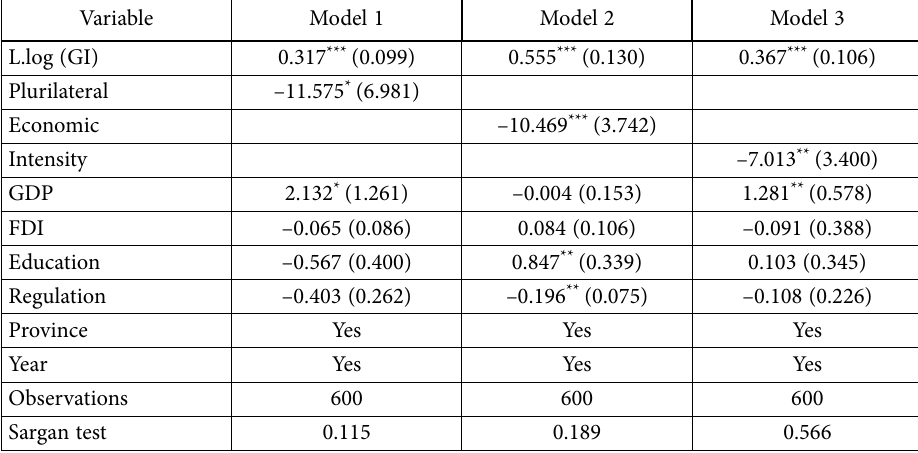
Table 4. Estimation results of the DIF-GMM